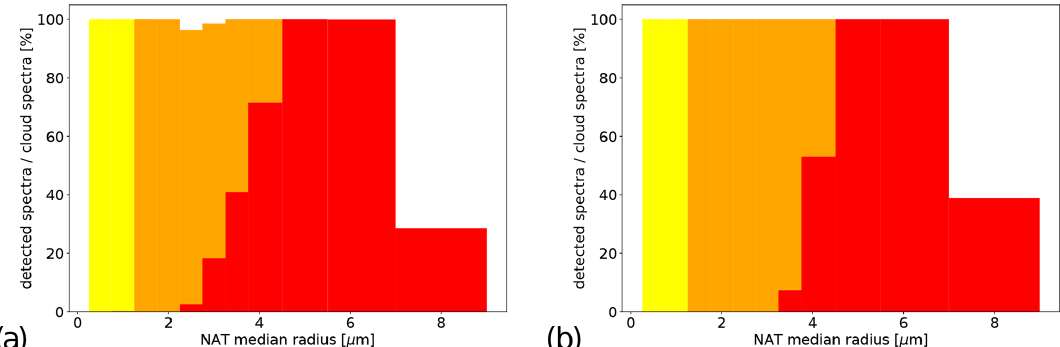
Figure 4. The histograms of the proportion of the detected spectra (NAT) per simulated cloud spectra in each size bin. The colours illustrate the different cases (1–3): case 1 (sNAT) is shown in yellow, case 2 (mNAT) is shown in orange, and case 3 (lNAT) is shown in red. For a description of the different cases, see the text. In panel (a) , the CI threshold value to detect a spectrum as a cloud spectrum is 5.0 (about 365000 cloud spectra in total), whereas the threshold in panel (b) is 3.0 (about 197000 cloud spectra in total).